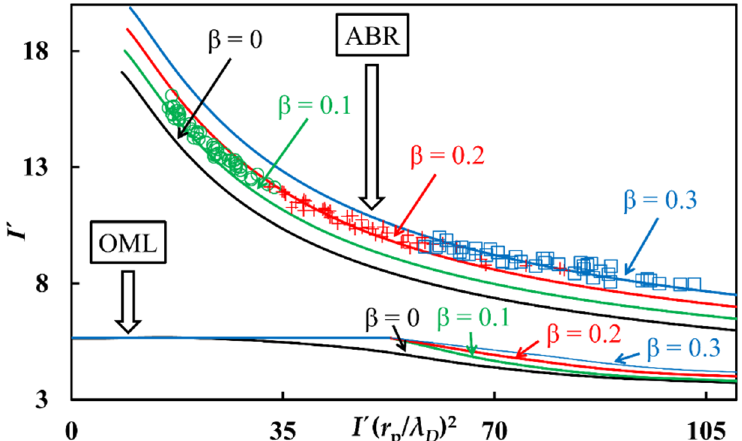
Figure 14. Sonin plot including the experimental data (symbols) and theoretical curves (solid lines) for argon plasmas. Circles mean 0.08 ≤ β ≤ 0.15, crosses mean 0.16 ≤ β ≤ 0.25 and squares mean 0.26 ≤ β ≤ 0.34. Reproduced with permission from Díaz Cabrera et al., Plasma Sources Science and Technology; Reprinted with permission from ref. [18]. Copyright 2015 IoP.